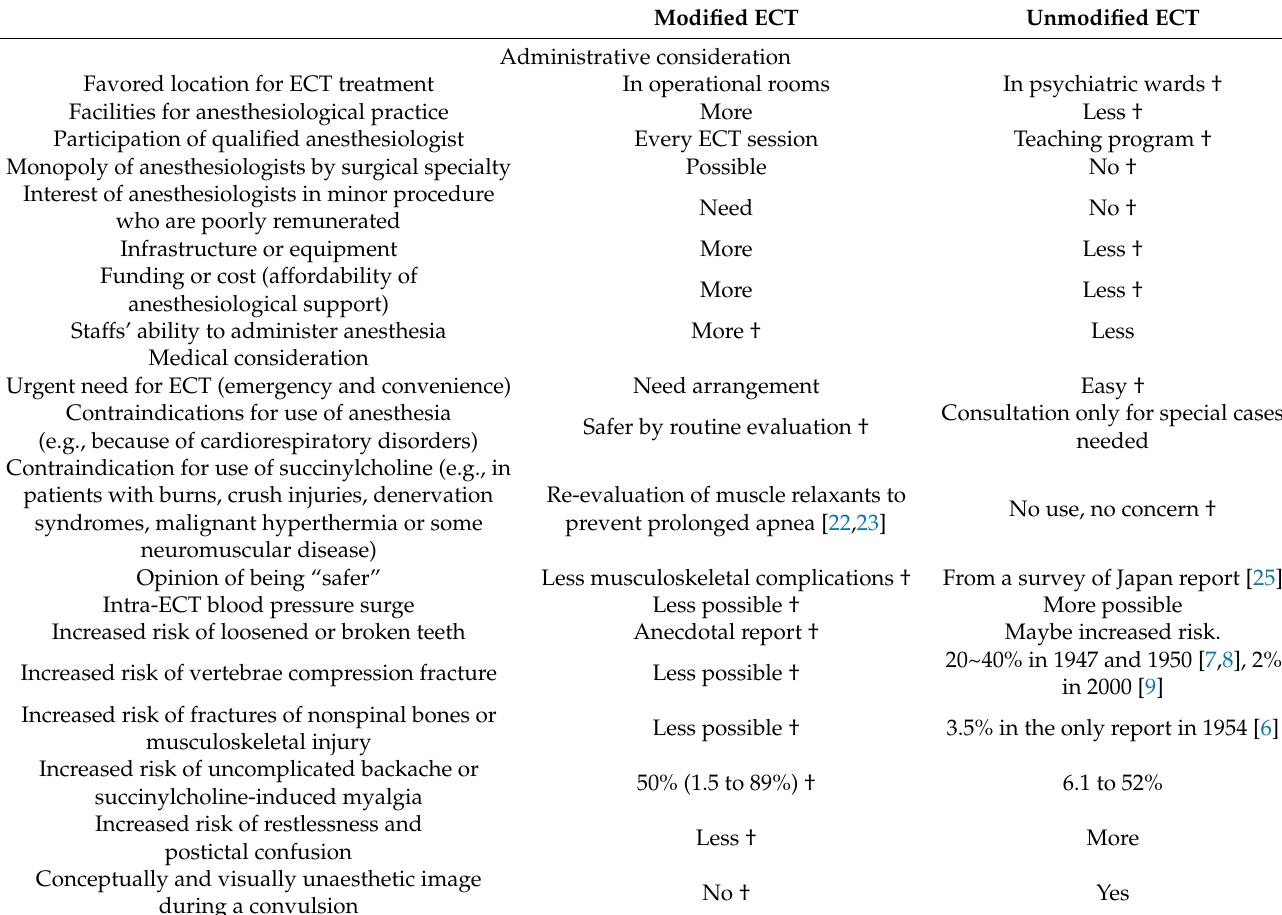
Table 1. Comparison of advantages of modified and unmodified electroconvulsive therapy